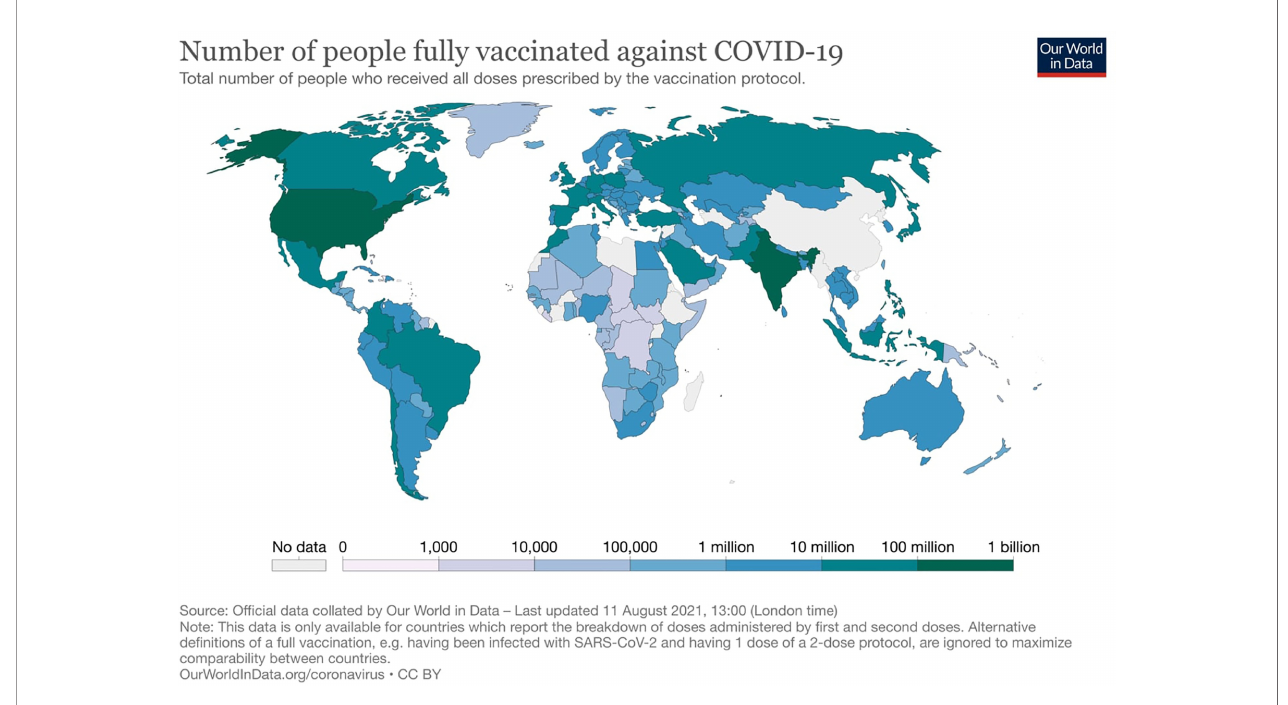
FIGURE 1 | Distribution of the total number of people that have been fully vaccinated against